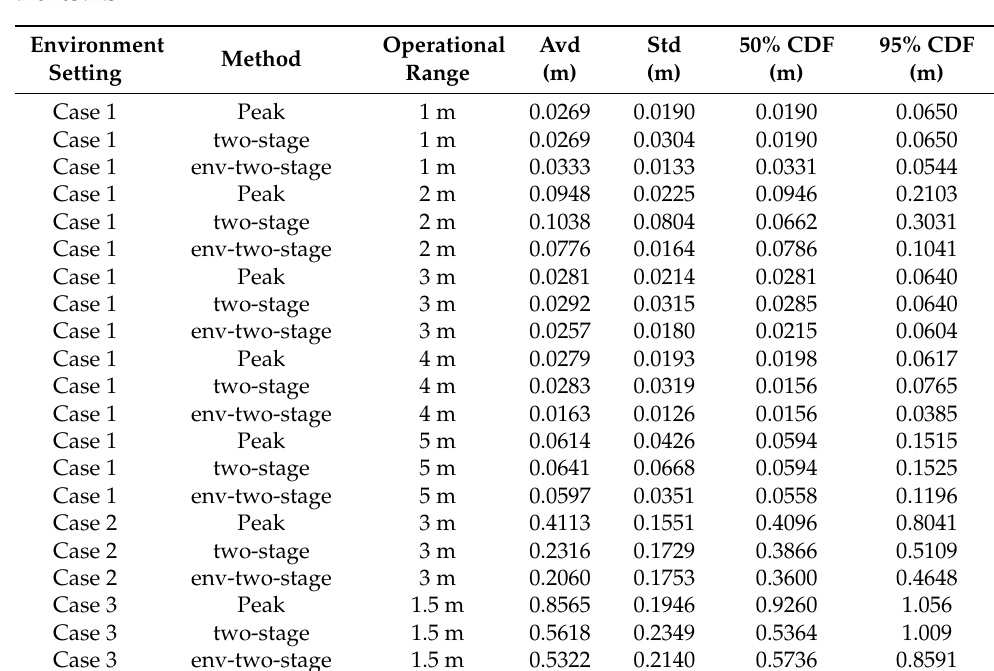
Figure 28. Experiment results in the canteen situation of NLoS. ( a ) box figure of experimental error. ( b ) CDF of experimental error. Table 3. Summary of all experimental results. Avd and Std are the average and stand error of the